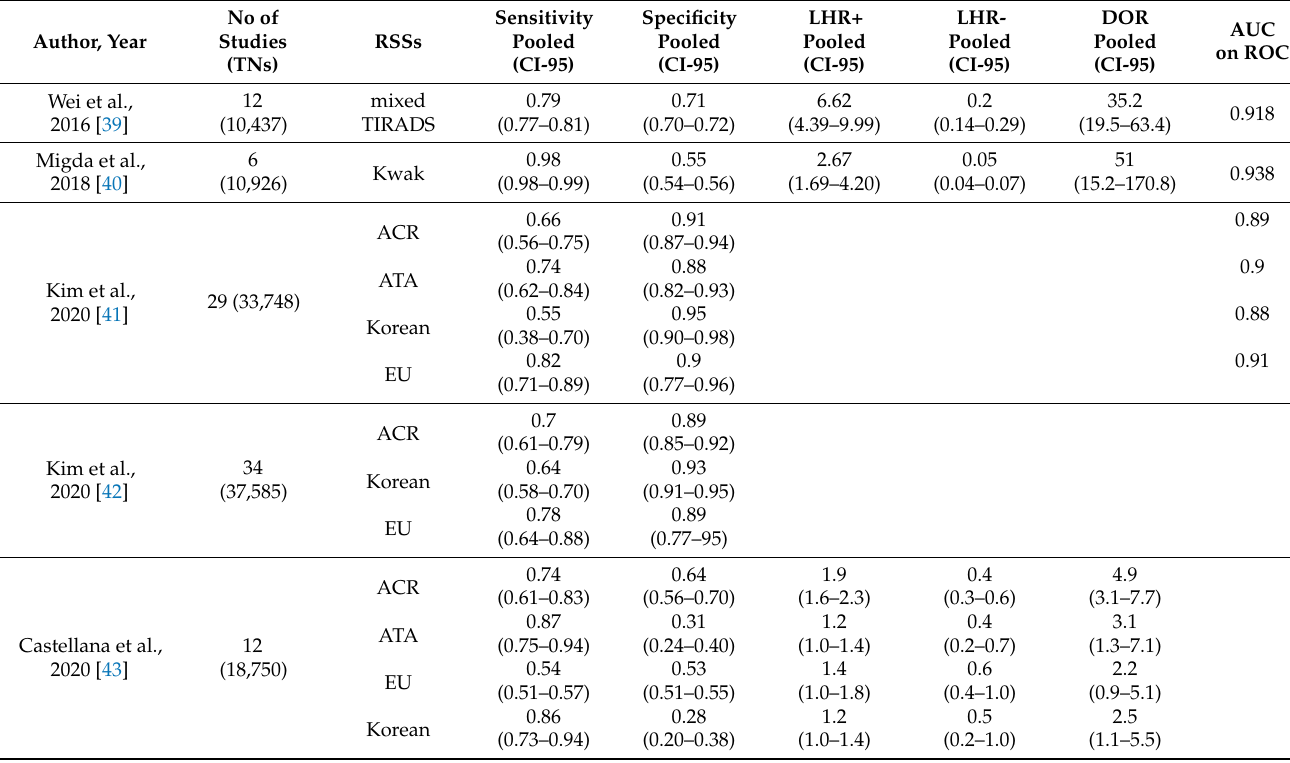
Table 6. Overview of meta-analyses regarding the diagnostic performance of ultrasound risk stratification systems (RSSs) for thyroid nodules